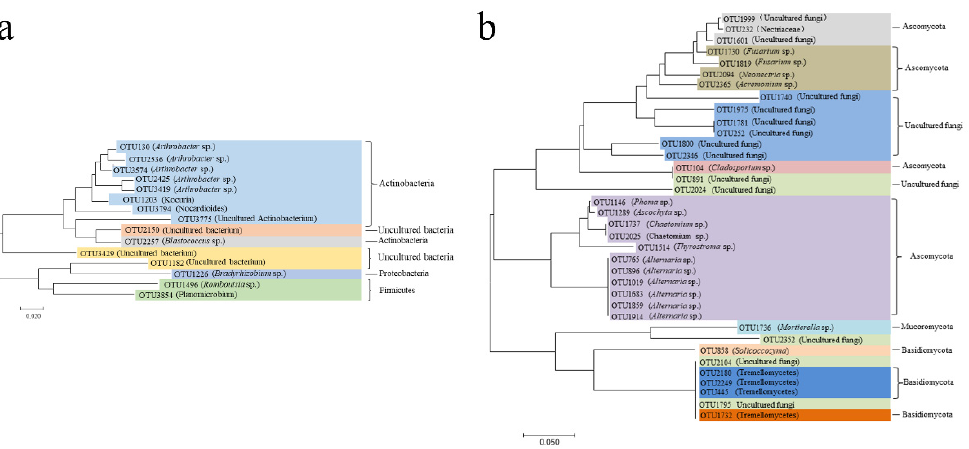
Figure 3. Phylogenetic tree of the core bacterial communities in the rhizospheres of nine grape cultivars ( a ). Phylogenetic tree of the core fungal communities in the rhizospheres of nine cultivars of grapes ( b ).